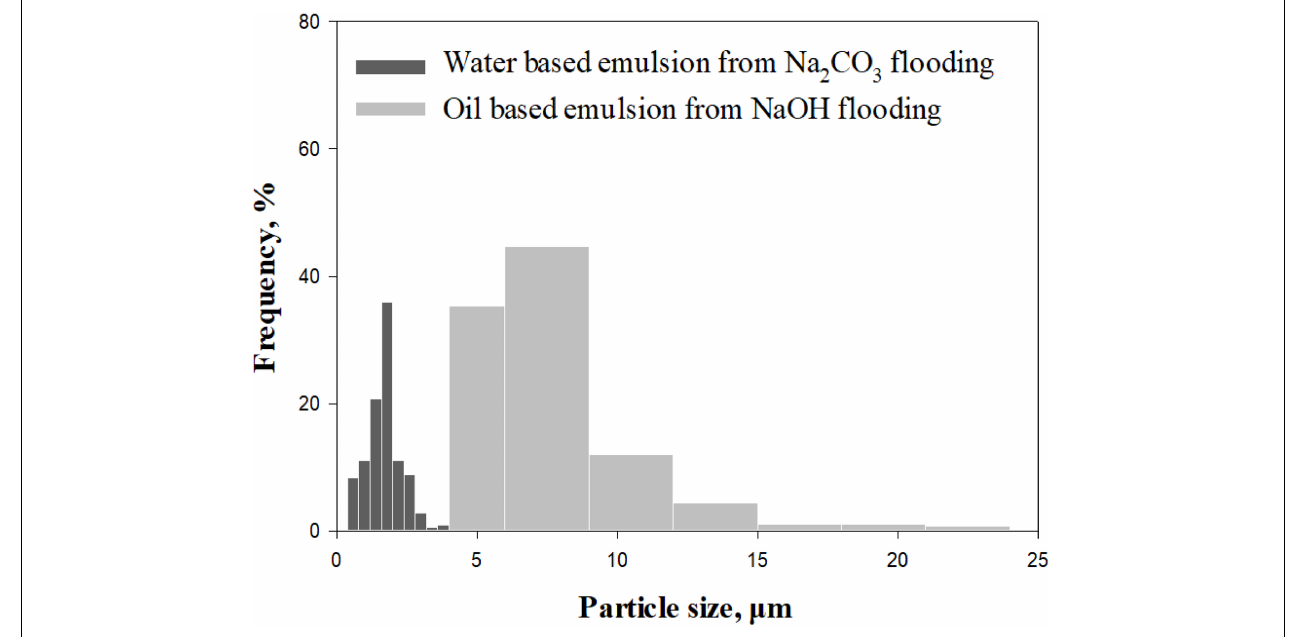
FIGURE 14 | Emulsion particle size distribution